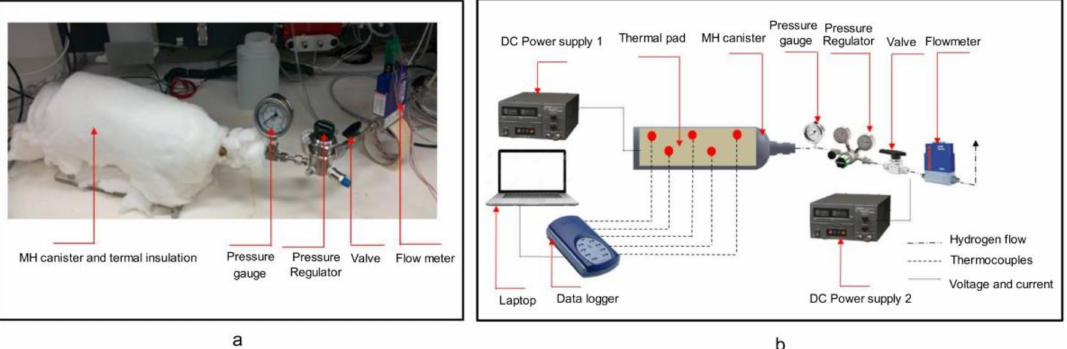
Figure 2. ( a ) The experimental set-up of the MH canister (MmNiMnCo, 800 sl) to study its hydrogen discharge rate behavior with heat addition using the thermal pads wrapped around the canister (mimicking the heat supplied by the fuel cell); ( b ) Schematic diagram of the experimental set-up used to study the hydrogen discharge rate of the MmNiMnCo, 800 sl MH canister with thermal